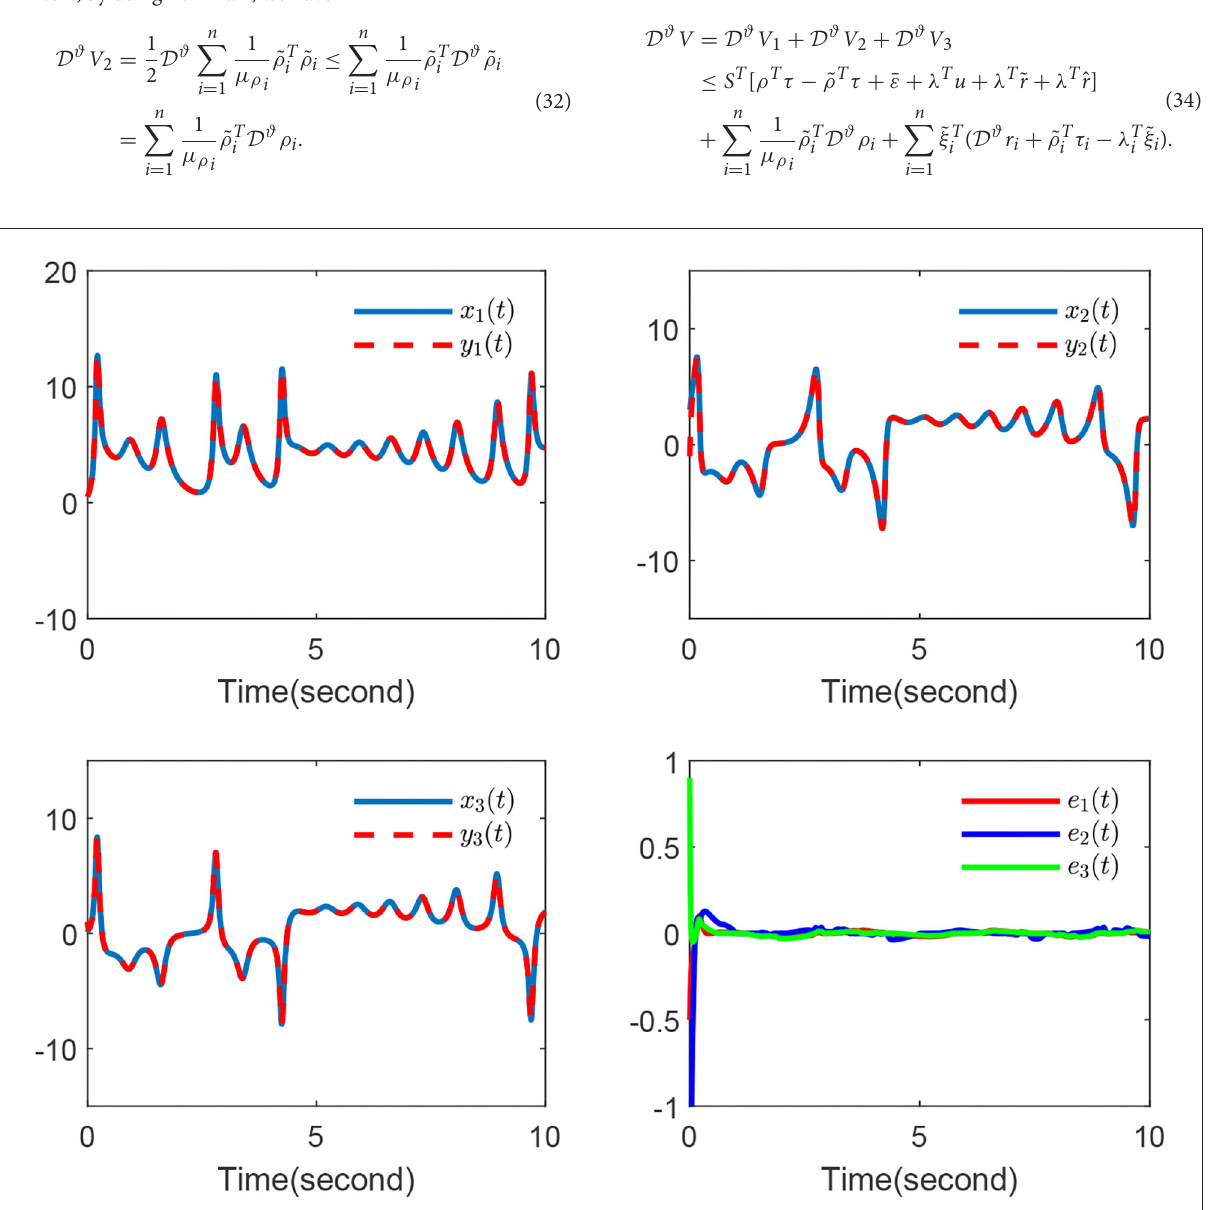
FIGURE2 The synchronization performance of the master-slave